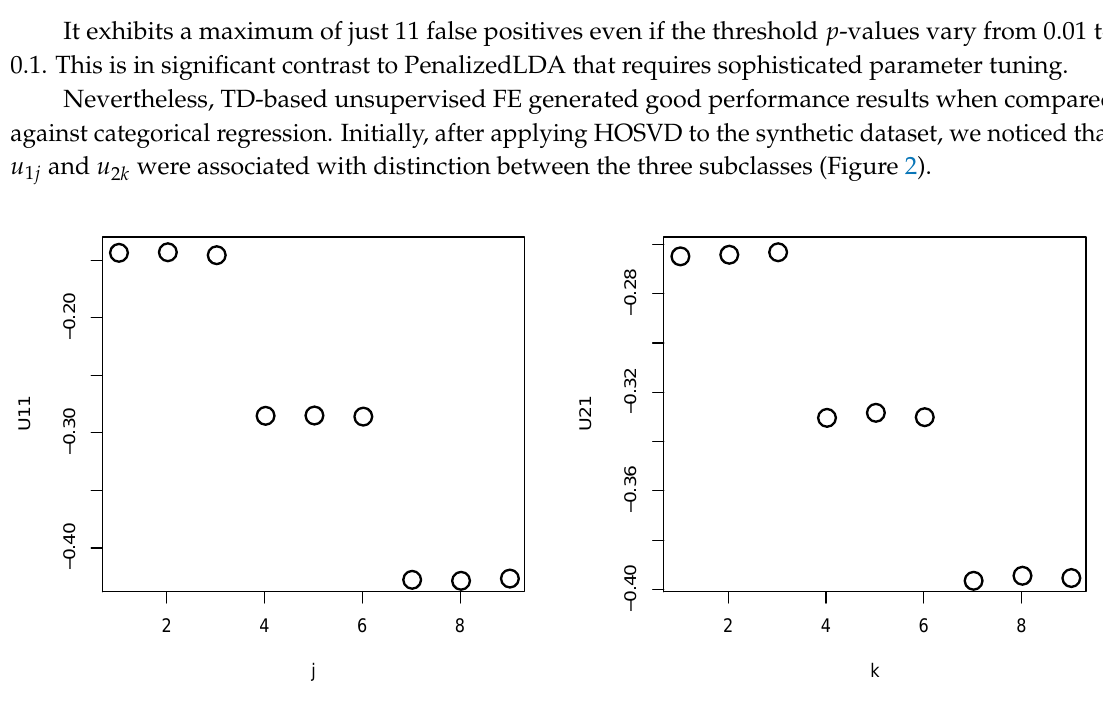
Figure 2. u 1 j and u 1 k obtained when HOSVD is applied to the synthetic dataset. Averaged over 100 independent